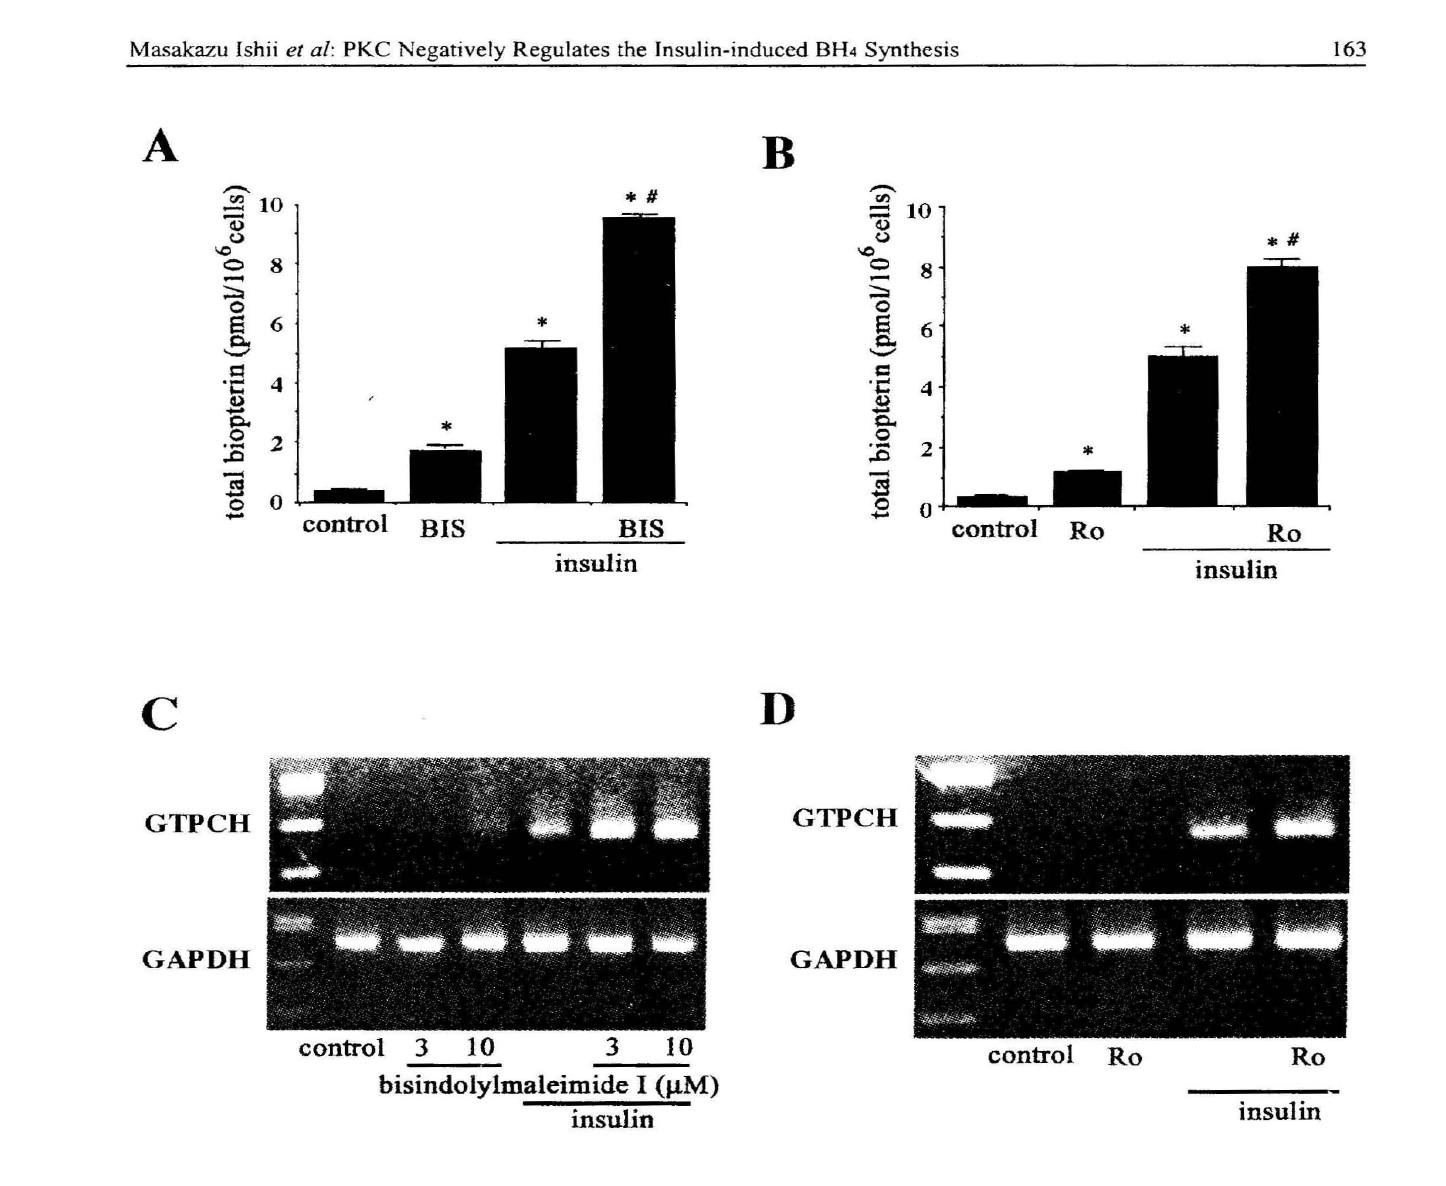
Figure 1. Effects of bisindolylmaleimide I and Ro 31-8220 on insulin-induced BH4 synthesis and expression of GTPCH mRNA in endothelial cells. A,B: Cells were pretreated with bisindolylmaleimide I (10 j.lM; A) or Ro 31 -8220 (2 j.lM; B) for 30 min, and then incubated with insulin (10 j.lg/ml) for 24 h. Results are the means ± S.E.M. of 8 assays. *Significantly different from control (p<0.05). #Significantly different from insulin-treated group (p<0.05). C,D: Cells were pretreated with bisindolylmaleimide I (3 or 10 j.lM; C) or Ro 31-8220 (2 j.lM; D) for 30 min, and then incubated with insulin (10 j.lg/ml) for 8 h. Total RNA was prepared from the cells, and was amplified by RT-PCR using primers for GTPCH or GAPDH. DNA size markers in the left-most lane corre spond to (bp): 525, 500,400 and